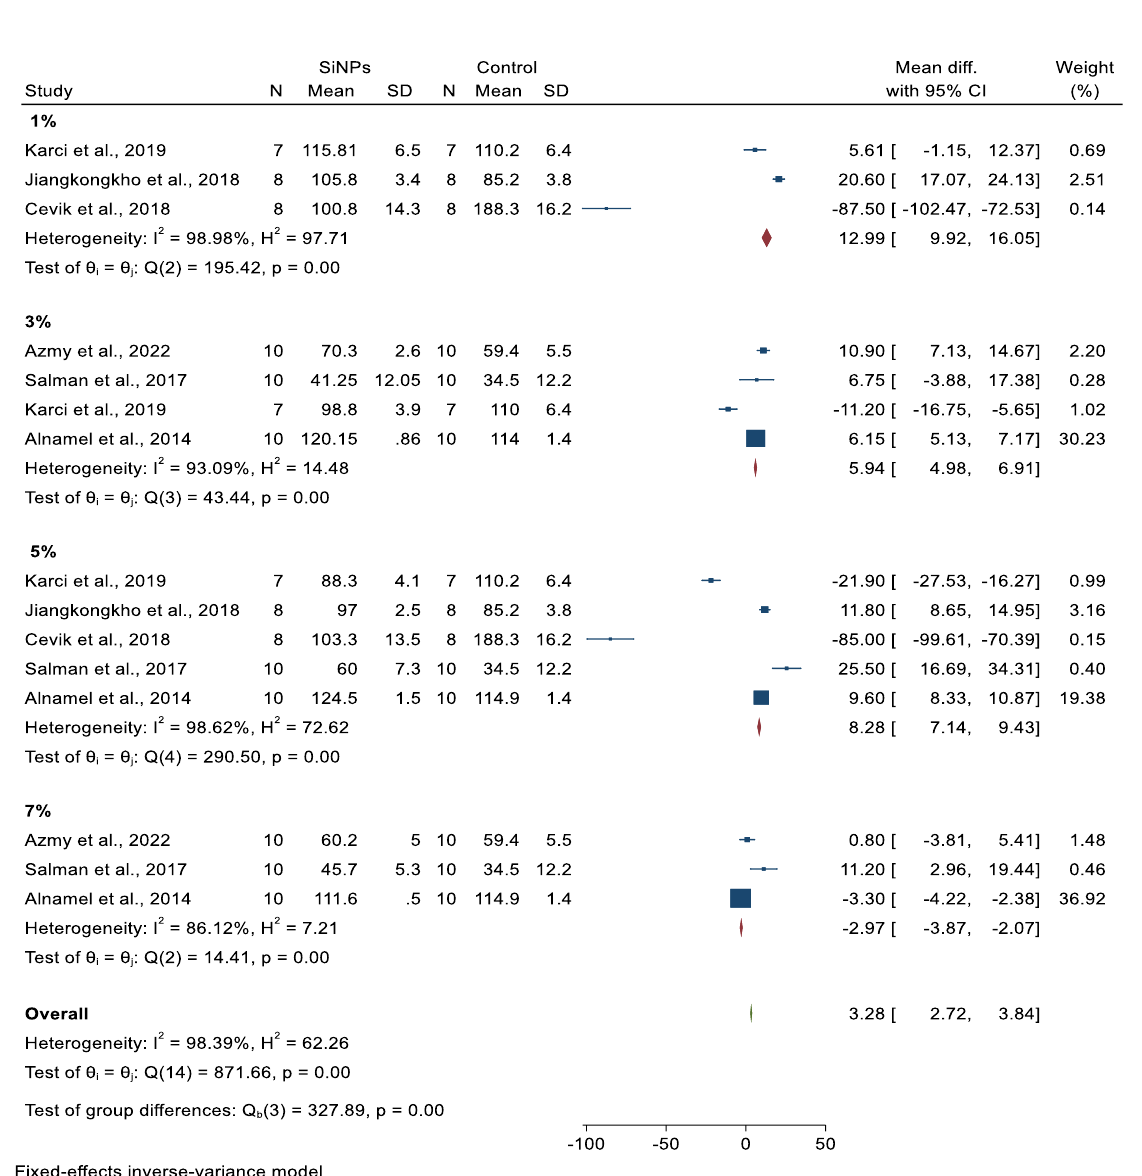
Fig. 2. Forest plots showed that adding 1%, 3%, 5%, and 7% SiNPs significantly affects flexural